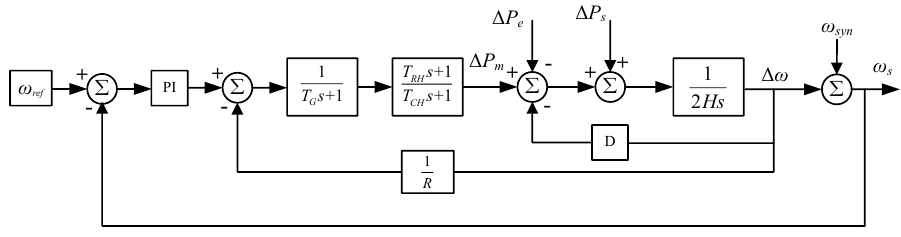
Figure 3. Block diagram model of a power system grid with load frequency